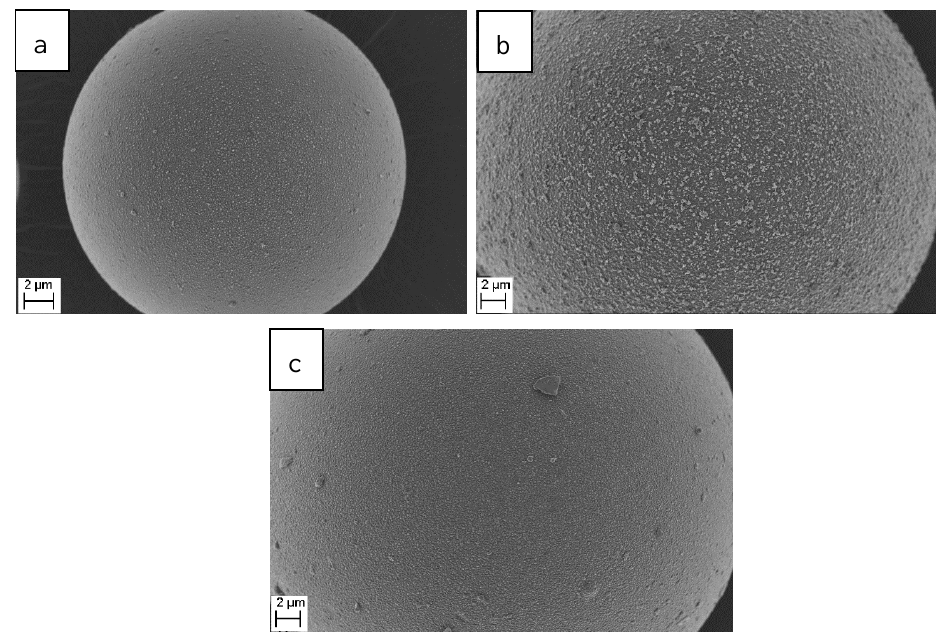
Figure 1. Exemplary SEM-images of the reference micro glass spheres coated via PVD (( a ): iM16K-ZF: 19 nm; ( b ): S38HS: 34 nm; and ( c ): Type S: 36 nm). An almost homogeneous aluminum coating